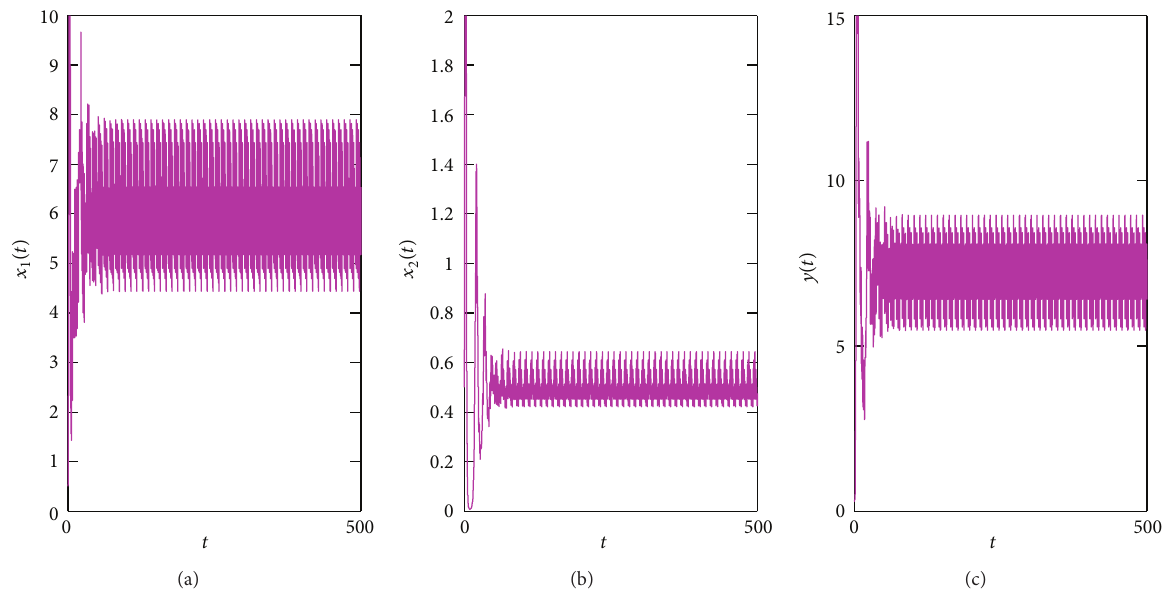
Figure 8: Dynamical behavior of system (22); the parameter values are as follows: 𝑟 = 5, 𝜏 = 0.5, 𝜔 = 0.2, 𝛽 = 0.6, 𝑘 = 0.2, 𝑑 1 = 0.15, 𝑑 2 = 0.2, 𝑑